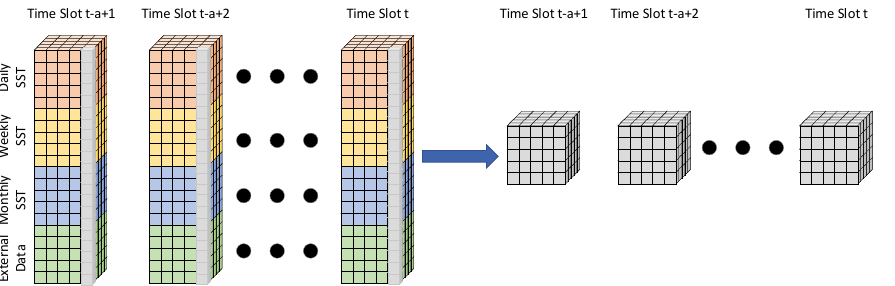
Figure 7. The structure of the Cross Scale Fusion (CSF) sub-layer, where the learned spatio-temporal features of different scales of SST and external